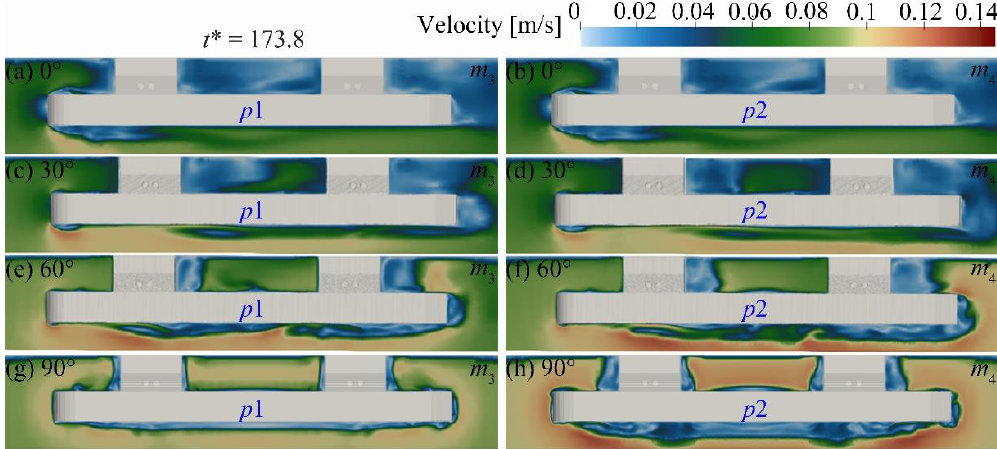
Figure A5. Comparison of the velocity field around the semi-submersible platform at different directions at profile m 1 and m 2 .